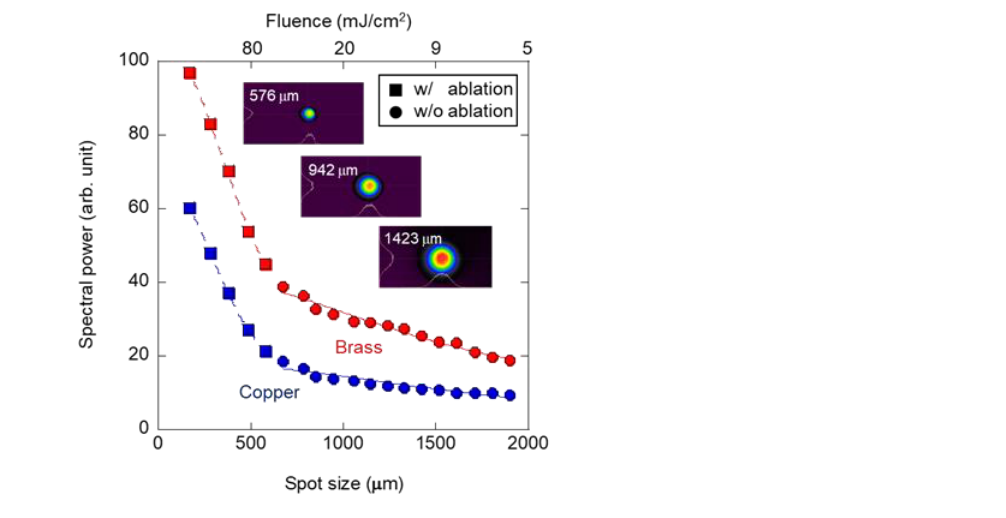
Figure 7. Spot-size dependence of vibrational power induced by single-frequency low-energy laser excitation.